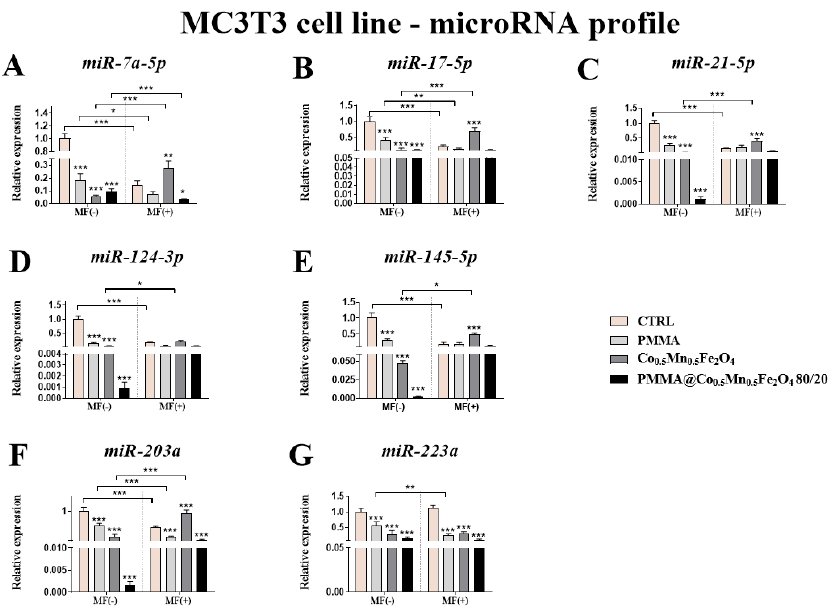
Figure 11. The impact of PMMA and its modification on the microRNA profile associated with osteoblastogenesis and osteoclastogenesis expression of miR-7a-5p ( A ), miR-17-5p ( B ), miR-21-5p ( C ), miR-124-3p ( D ), miR-145-5p ( E ), miR-203a ( F ) and miR-223a ( G ) in the magnetic field condition towards mouse pre-osteoblasts (MC3T3-E1 cell line. Statistical differences are indicated by * p < 0.005; ** p < 0.001 and *** p < 0.0001.